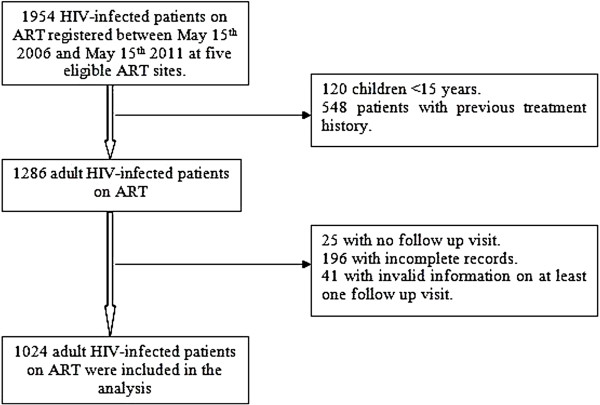
Profile of the study cohort.